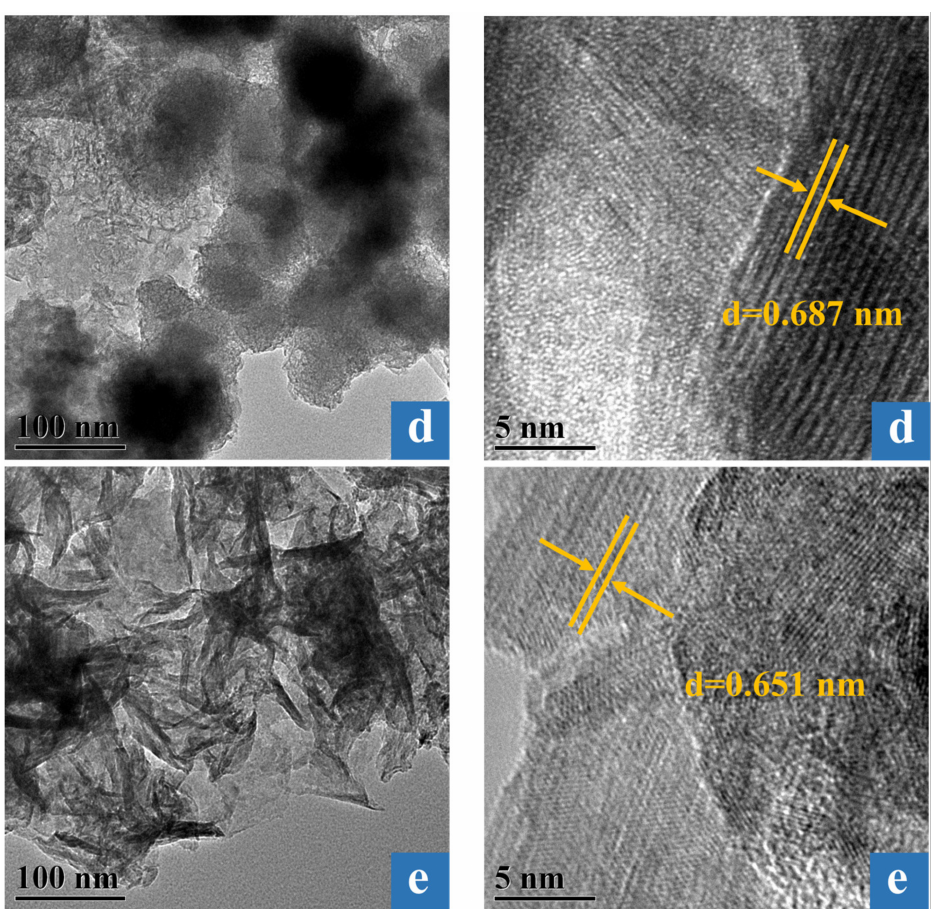
Figure 5. TEM images of the five catalysts: ( a ) 7-MnO 2 , ( b ) 9-MnO 2 , ( c ) 11-MnO 2 , ( d ) 13-MnO 2 , ( e ) 14-MnO 2